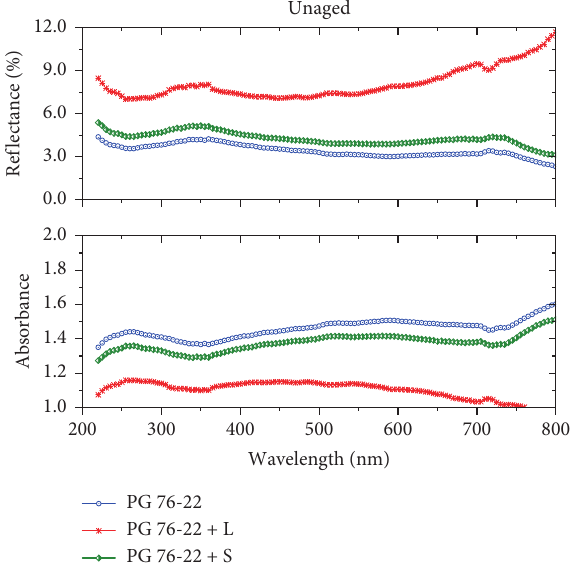
Figure 6: Reflectivity and absorbance of unaged warm PMA binders.